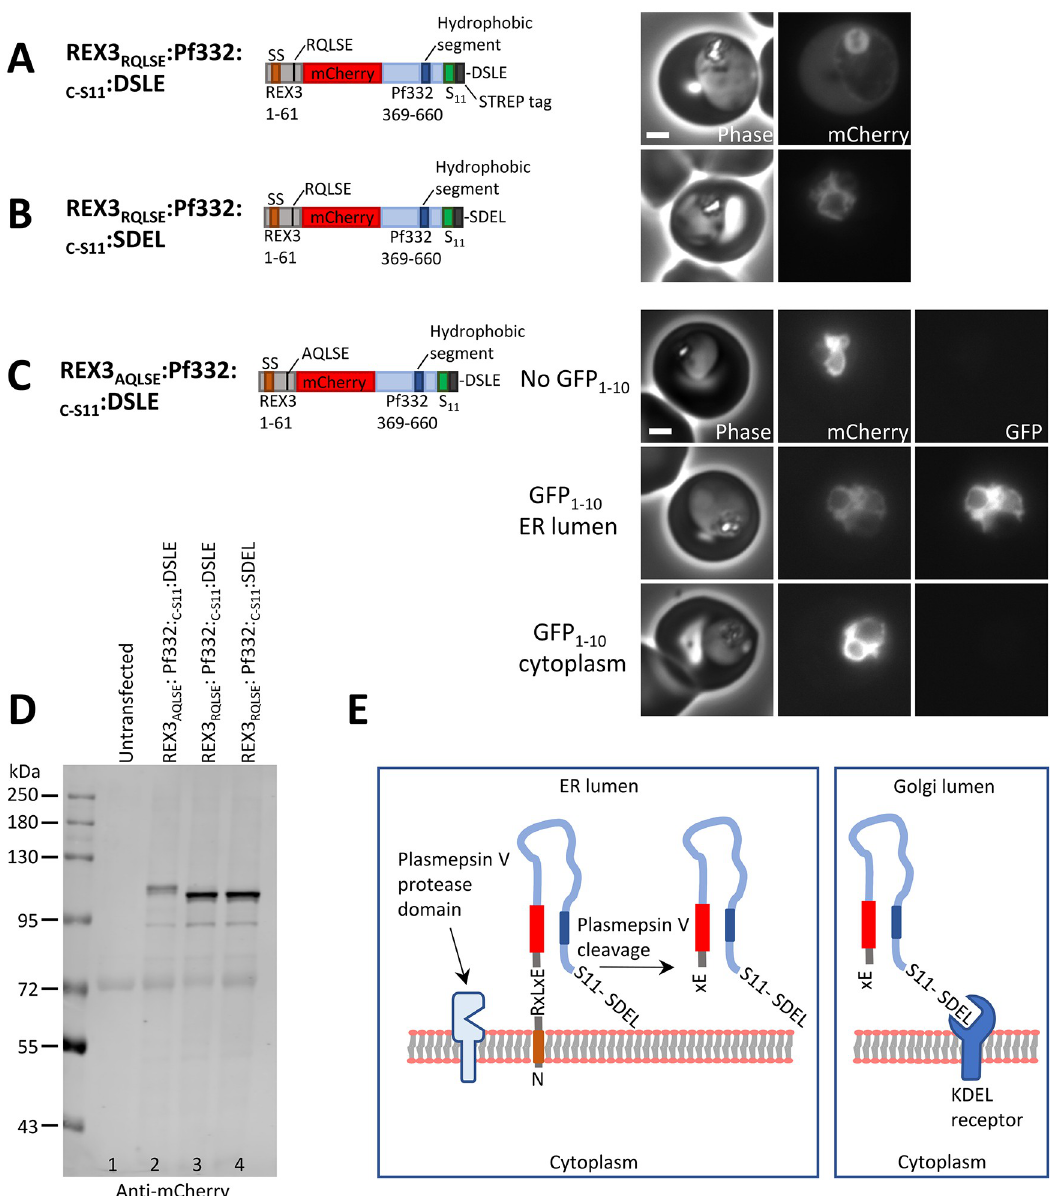
Fig 3. The putative TM segment of Pf332 translocates into the ER lumen. (A-B) Phase contrast and fluorescence images of parasites expressing the indicated proteins. (C) Phase and fluorescence images of parasites expressing REX3 AQLSE :Pf332: C-S11 :DSLE alone, or co-expressing either ER-lumenal GFP 1-10 or cytoplasmic GFP 1-10 , as indicated. Scale bar: 2 μ m. (D) Western blot of parasites expressing the indicated proteins (probed with an anti-mCherry antibody). (E) Cartoon representation of plasmepsin V cleavage of the PEXEL sequence in REX3 RQLSE :Pf332: C-S11 :SDEL within the ER and recognition of the C-terminal SDEL sequence in the Golgi lumen.